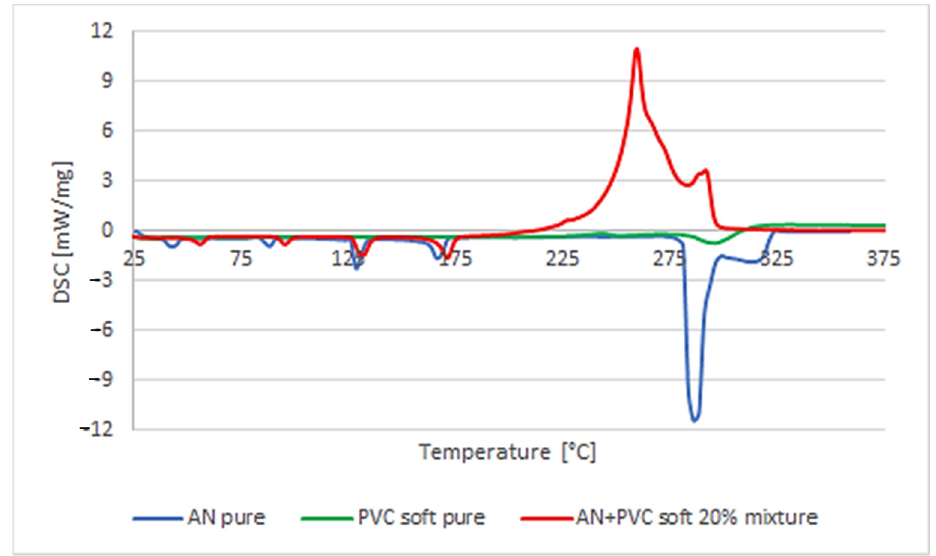
Figure 4. DSC analysis of pure AN, pure soft PVC (PVC-P), and their mixture (20%), heat rate 10 °C/min.